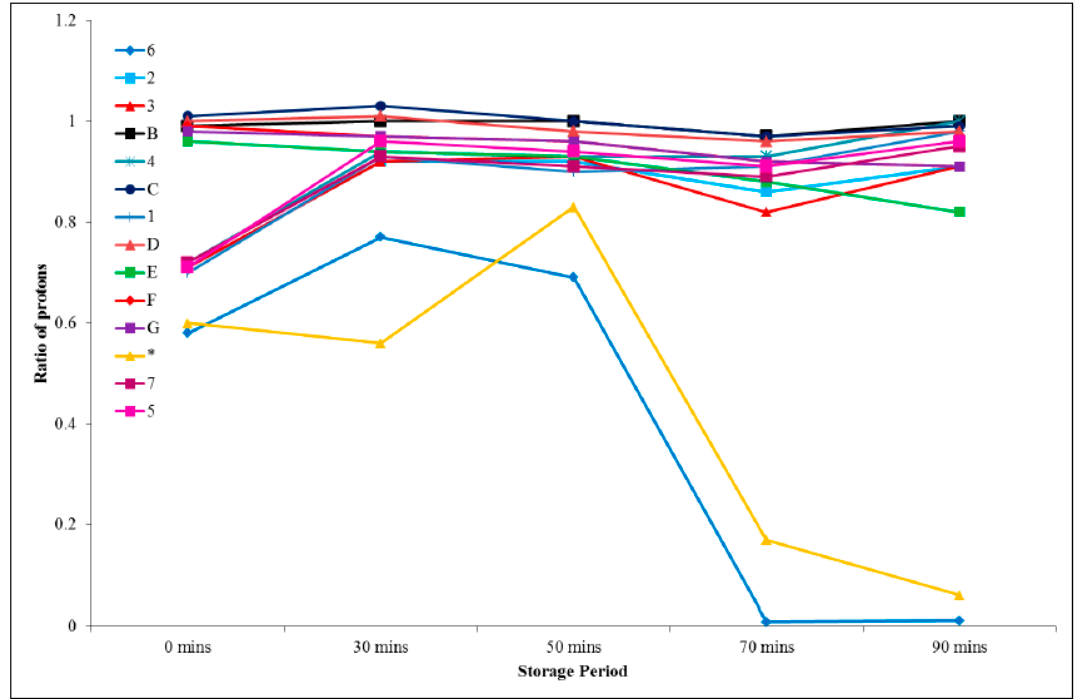
Figure 7. Ratio of proton integral change in a room-temperature-stored 1:1 formulation comprising PGE and 1-ethyl-3-methylimidazolium acetate.